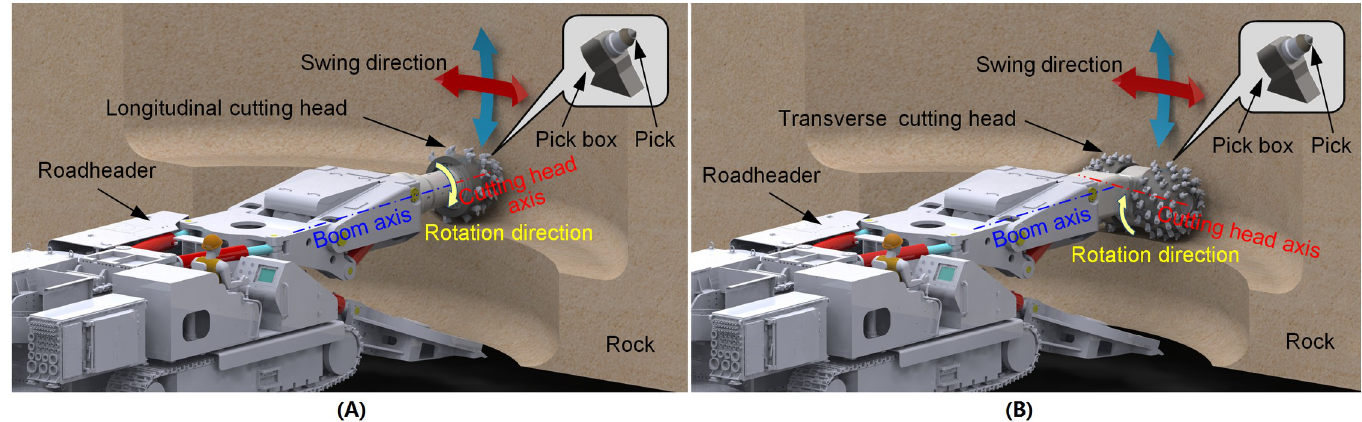
Fig 1. Two types of cutting head. (A) Milling process with longitudinal cutting head. (B) Ripping process with transverse cutting Head.